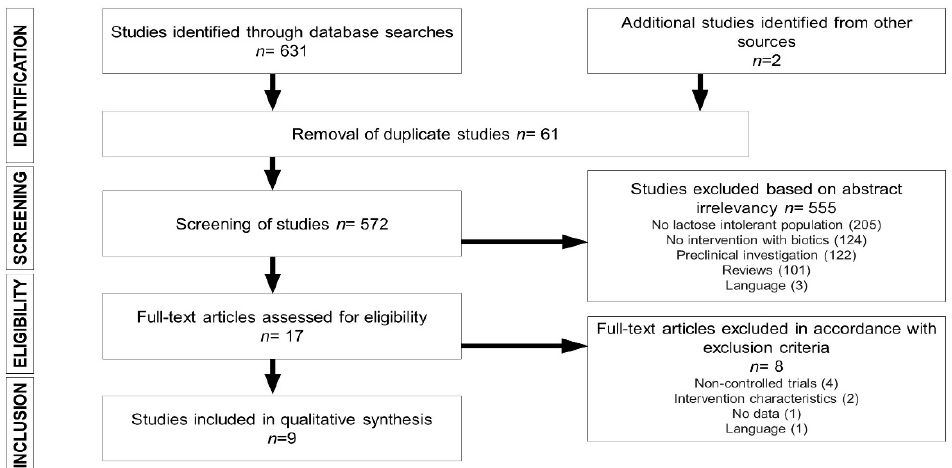
Figure 1. Flow chart depicting literature search process.